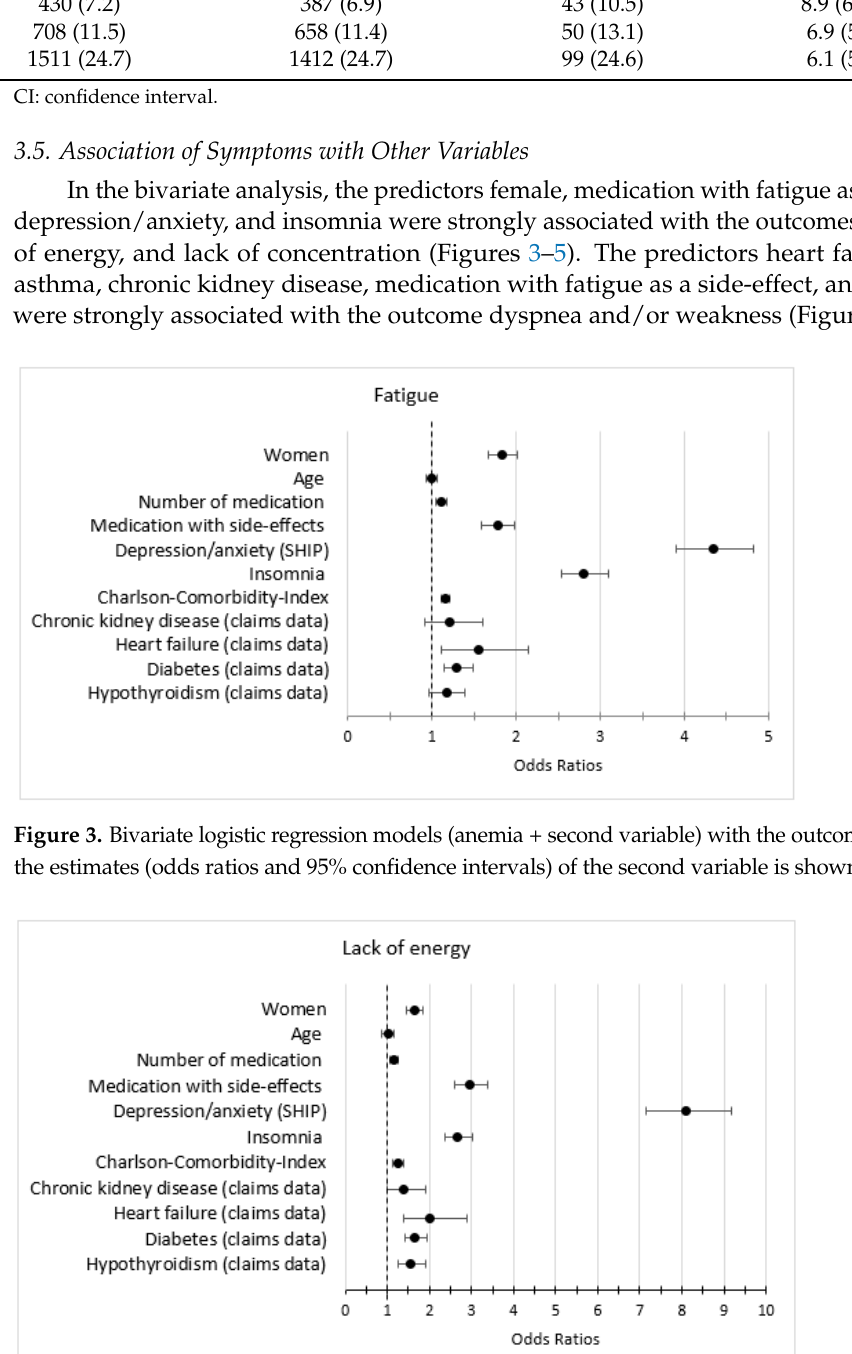
Figure 5. Bivariate logistic regression models (anemia + second variable) with the outcome lack of concentration; only the estimates (odds ratios and 95% confidence intervals) of the second variable is shown (weighted) .